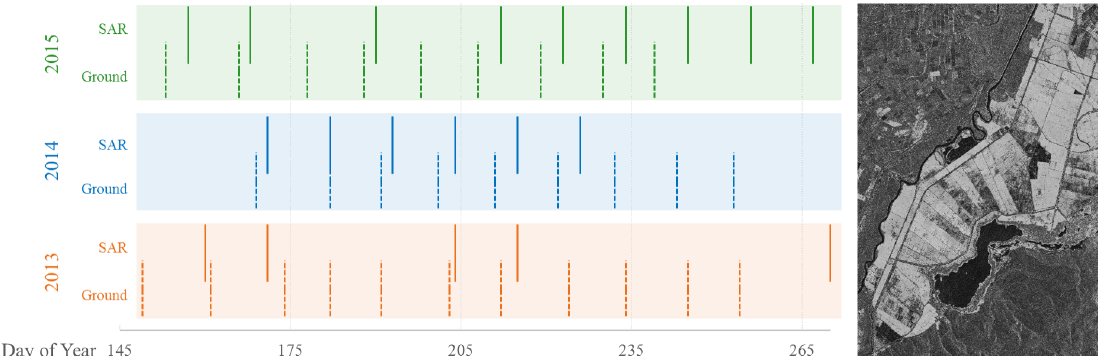
Figure 4. The ground and Synthetic Aperture Radar (SAR) data collection dates for the cultivation period between 2013 and 2015. On the right side, the VV channel PolSAR intensity image is also provided from the 30 June 2013. In the image, rice fields can be detected with their higher backscattering intensities.